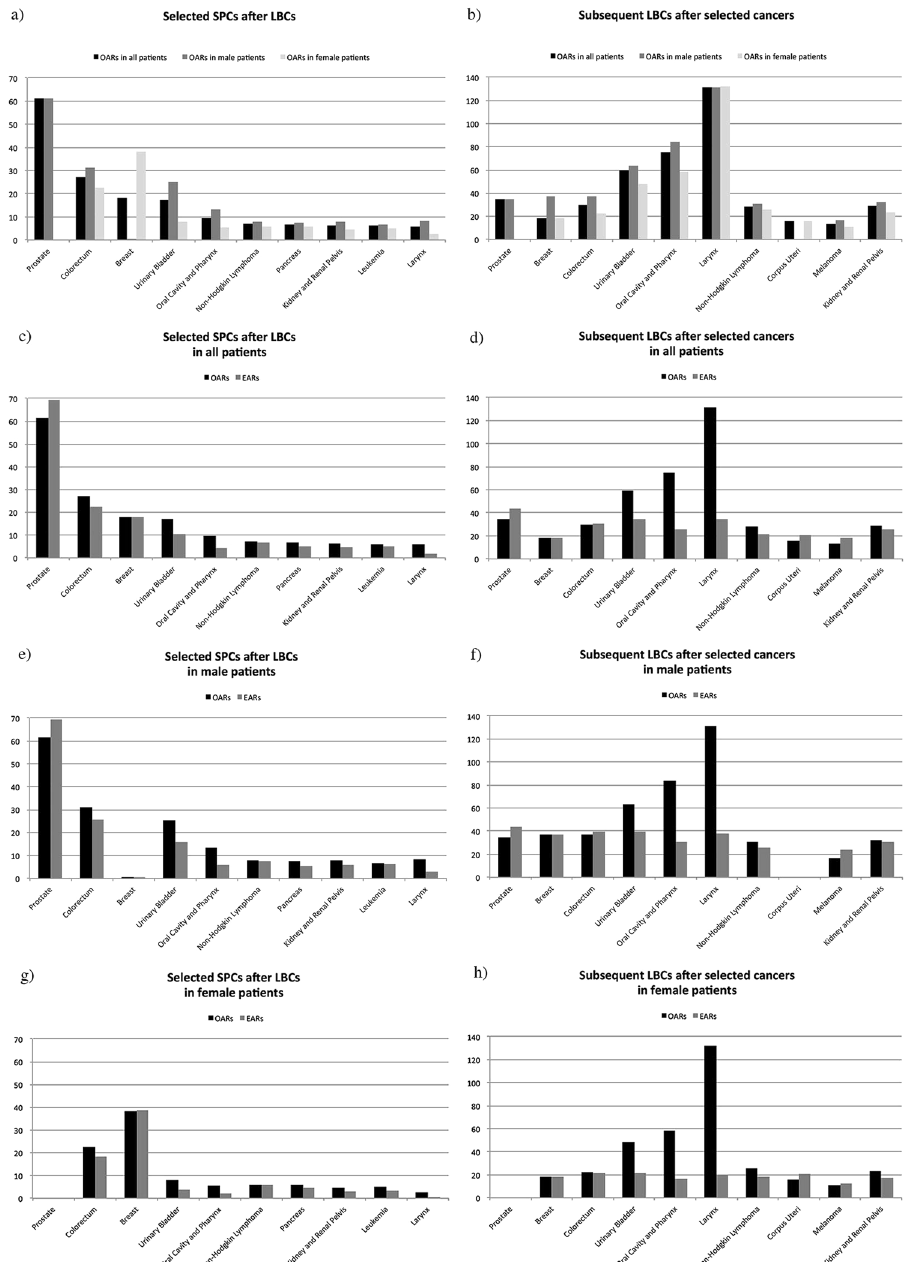
Figure 1. Observed annual risks (OARs) and expected annual risks (EARs) of selected subsequent primary cancers (SPCs) after LBCs and subsequent LBCs after selected cancers, by